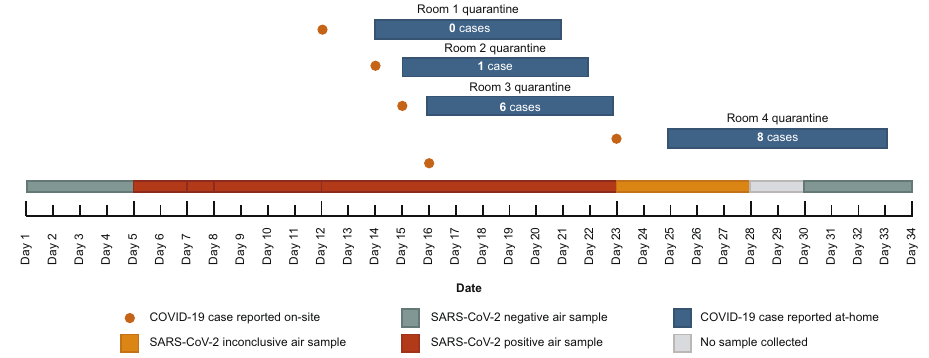
Fig. 1 | COVID-19 outbreak timeline. Con fi rmed COVID-19 cases and air sample SARS-CoV-2 RT-qPCR results in the congregate setting are plotted over time. Orange dots represent con fi rmed COVID-19 cases from individuals present in the building.BlueboxesshowthenumberofCOVID-19casesthatoccurredwhileclose